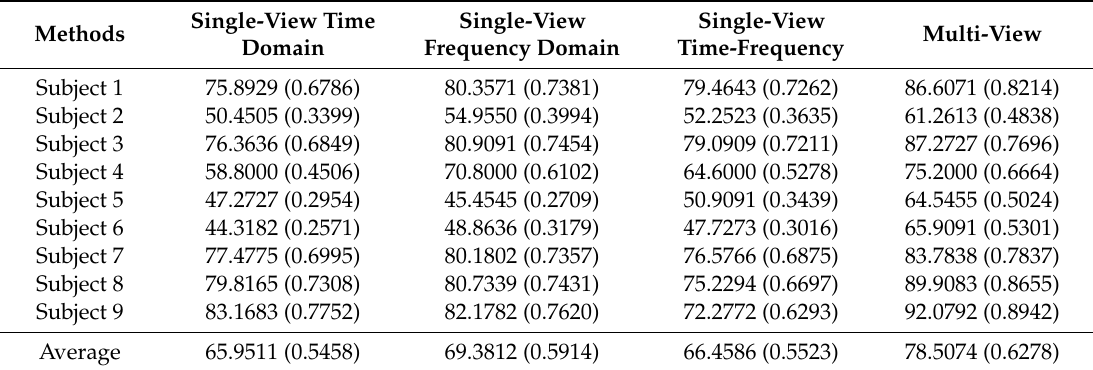
Table 1. Classification accuracy and kappa score comparison between Multi-view feature and Single-view applied on BCI competition IV dataset